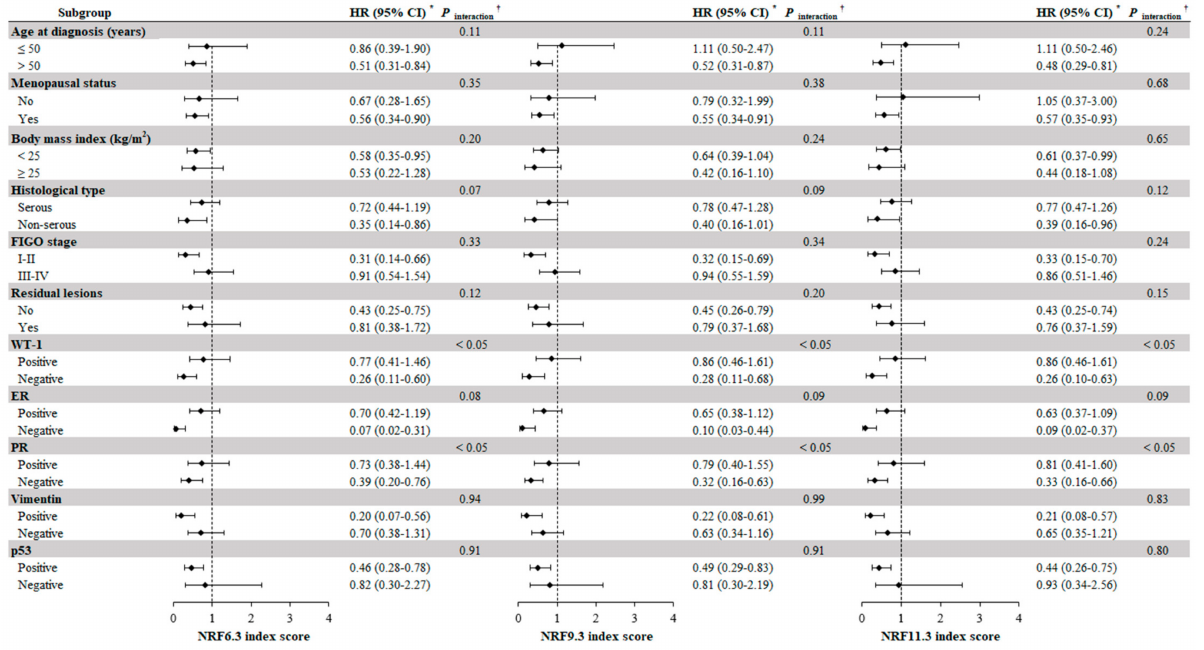
Figure 2. Subgroup analyses of clinical, demographic and immunohistochemical features for the associations of NRF index scores with OS among OC patients. * HRs and 95% CIs were estimated